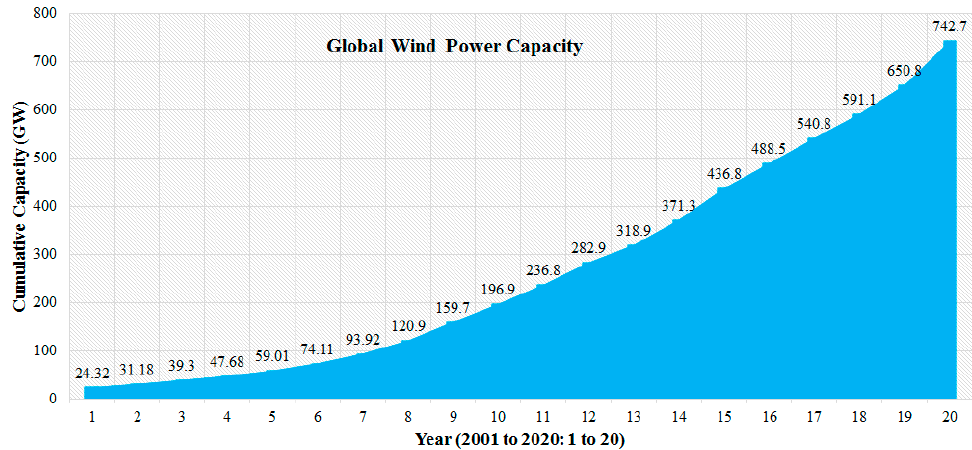
Figure 1. Global wind power cumulative capacity (GW) (2006–2019) [7,8].